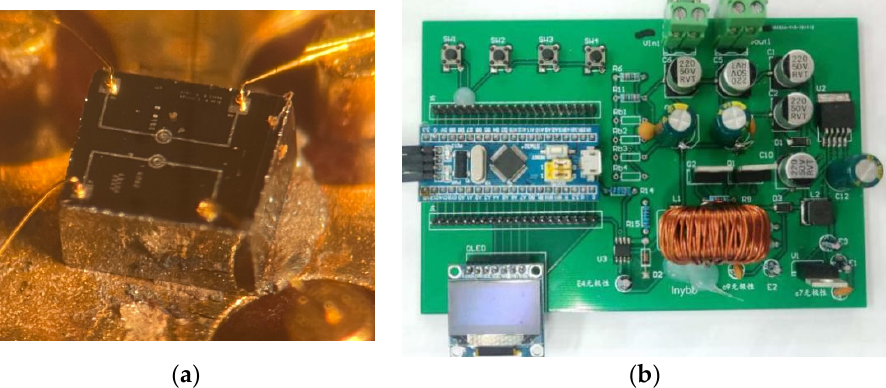
Figure 4. ( a ) Photograph of a dual-SPADs chip with one SPAD shaded; and ( b ) of the board devel- oped for the proposed